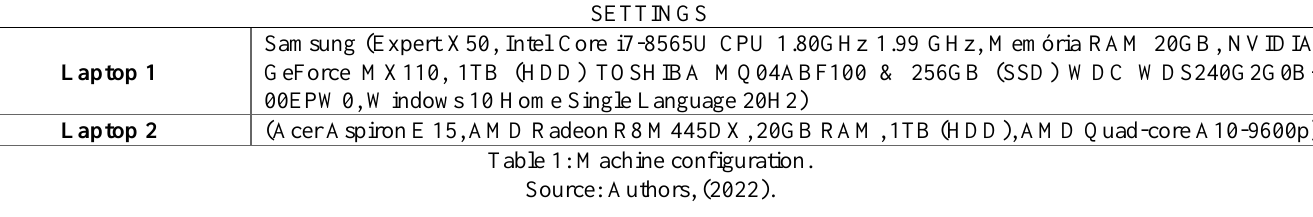
Table 1: Machine configuration. Source: Authors,